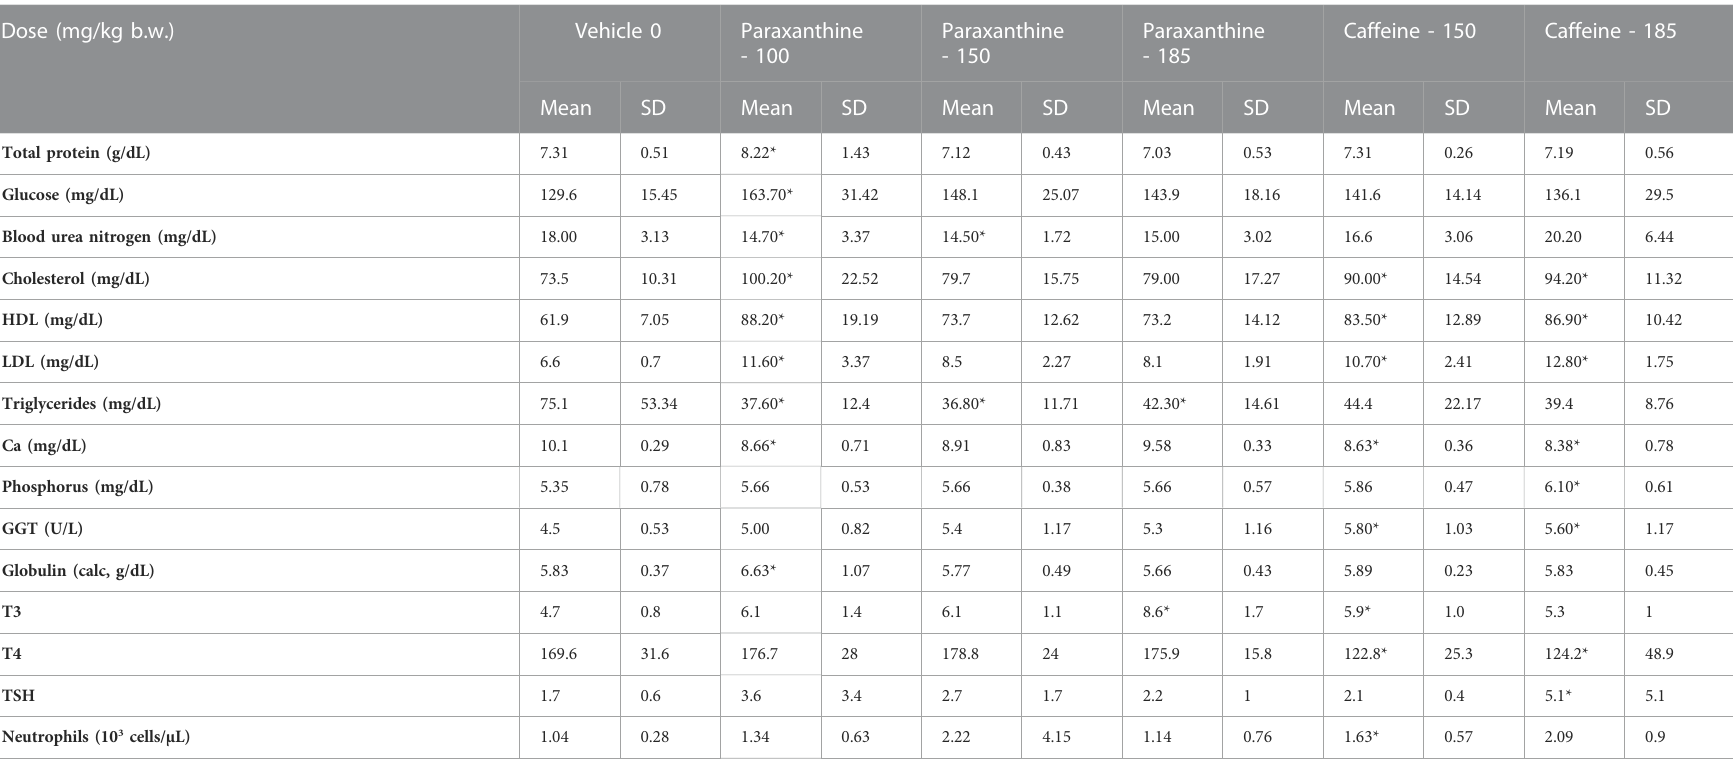
TABLE 5 Summary of clinical chemistry, hematology and hormone parameters assessed in main group females in the repeat-dose 90-day toxicity study. *Statistically signi fi cant (p < 0.05) with respect to the vehicle group. Dose (mg/kg